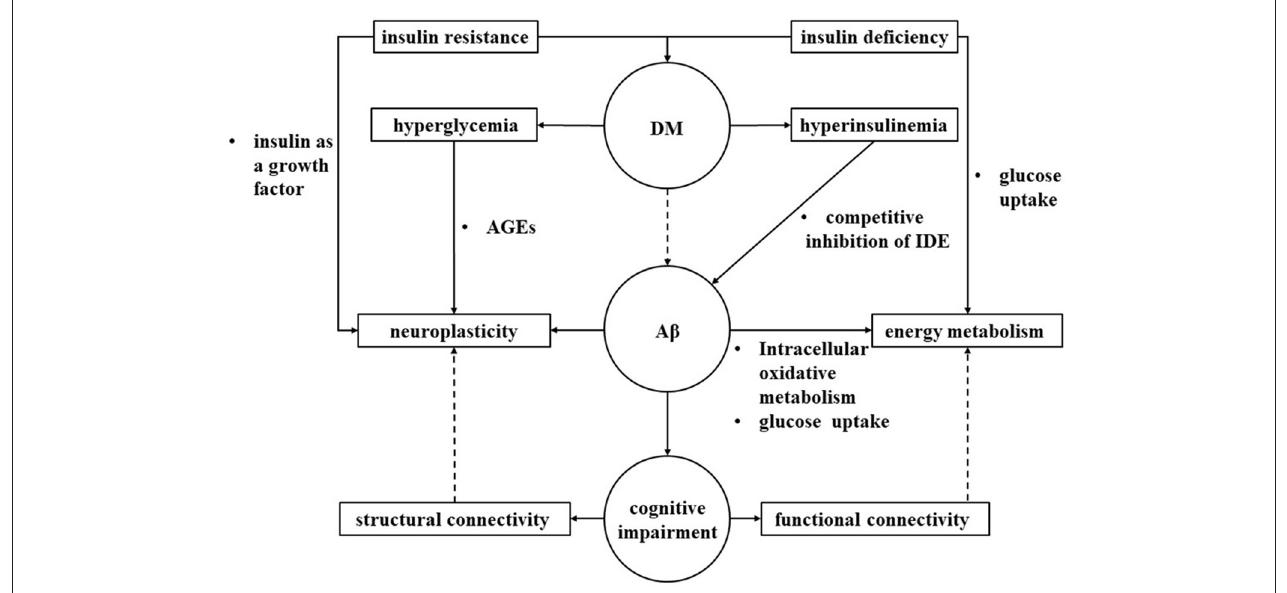
FIGURE 3 | Interaction of brain connectivity, neural plasticity and energy metabolism. We hypothesized that diabetes may lead to abnormalities in neuroplasticity and energy metabolism in the brain through multiple pathological pathways, ultimately leading to cognitive impairment that may reflect to MRI structural connectivity and functional connectivity, respectively. IDE, insulin degrading enzyme; AGEs, advanced glycation end products; DM, Diabetes mellitus; A β , amyloid beta.